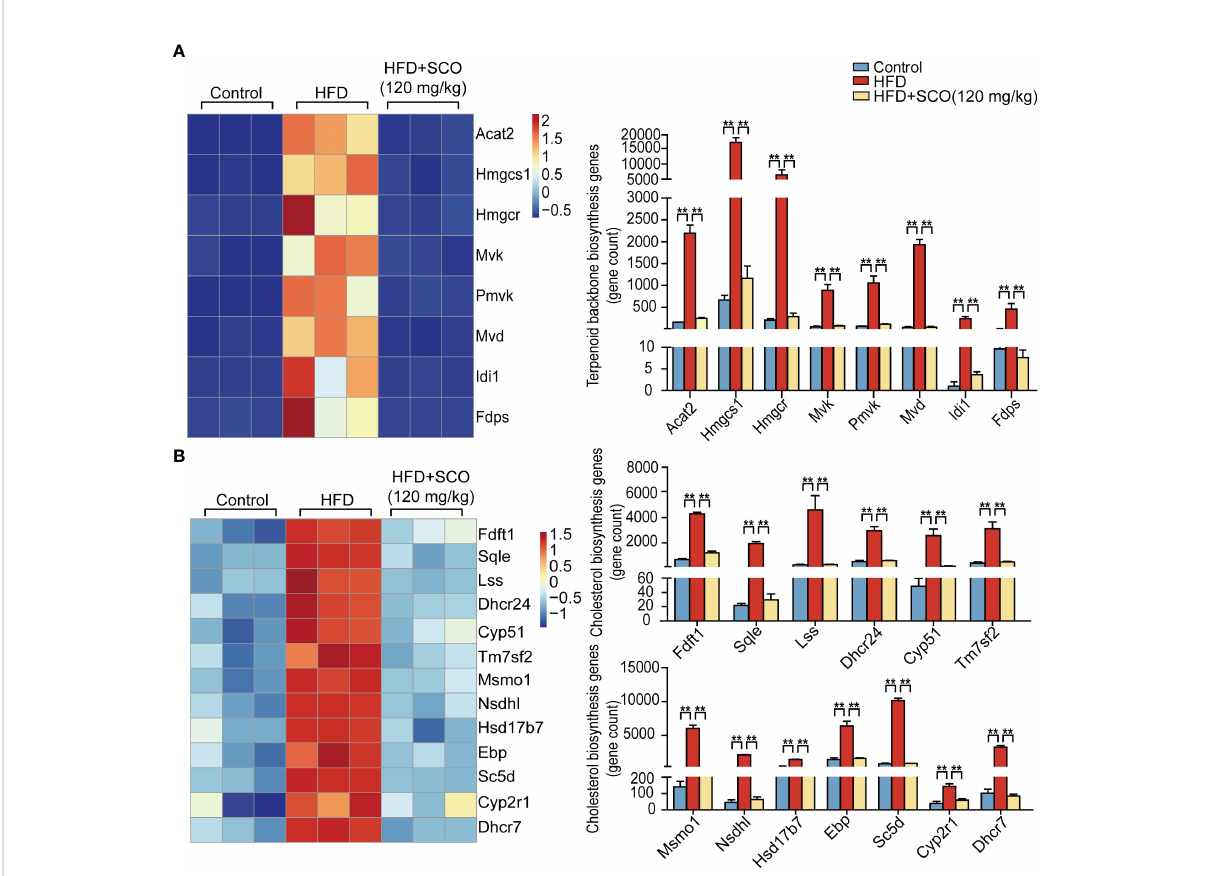
FIGURE 5 The differentially expressed genes of cholesterol biosynthesis in liver tissue. (A) Terpenoid backbone biosynthesis genes. (B) Cholesterol biosynthesis genes. ** Fold change ≥ 1.5 and P <